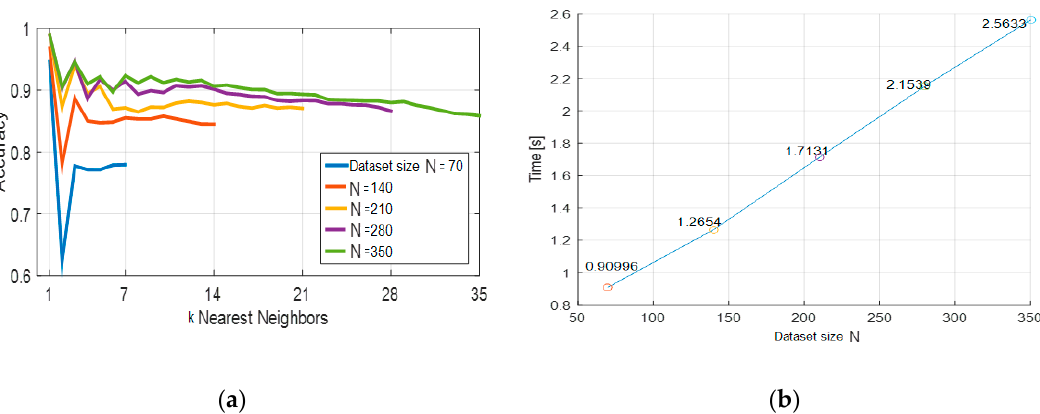
Figure 4. Related to the k -Nearest Neighbors ( k -NN) and Dynamic Time Warping (DTW) classification algorithm: ( a ) Accuracy for different dataset sizes N and number of neighbors k ; ( b ) Average time of classification versus the size N of the training set.